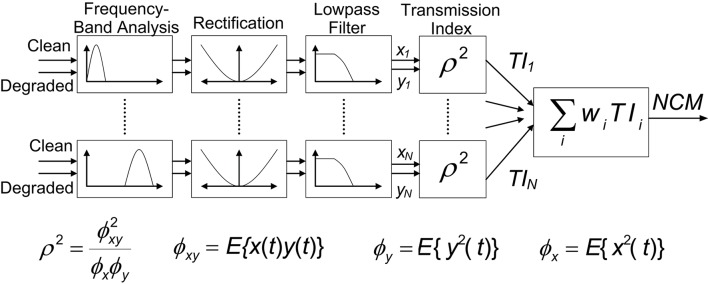
The normalized correlation metric (NCM, adapted from Goldsworthy, 2005). The NCM computation begins with the calculation of Transmission Indices for each of N frequency bands as the normalized correlation between the two signals of interest (clean and degraded/unprocessed or clean and processed). A weighted sum of the normalized correlations for each frequency band produces the NCM (see Materials and Methods).